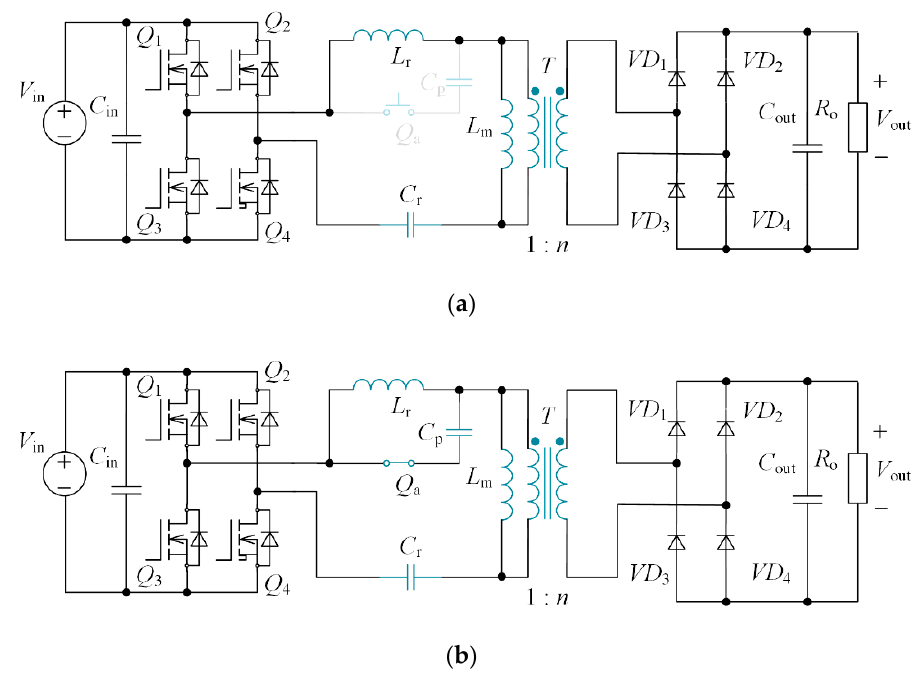
Figure 8. Two different working modes of the proposed converter: ( a ) LLC mode; ( b ) LCCL mode.